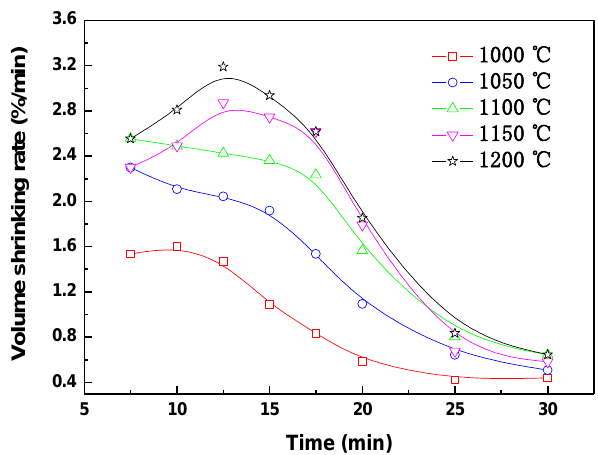
Figure 7. SEM images of the reduced pellets (at 30 min): ( a ) 1000 °C, ( b ) 1050 °C, ( c ) 1100 °C, ( d ) 1150 °C, and ( e ) 1200 °C.